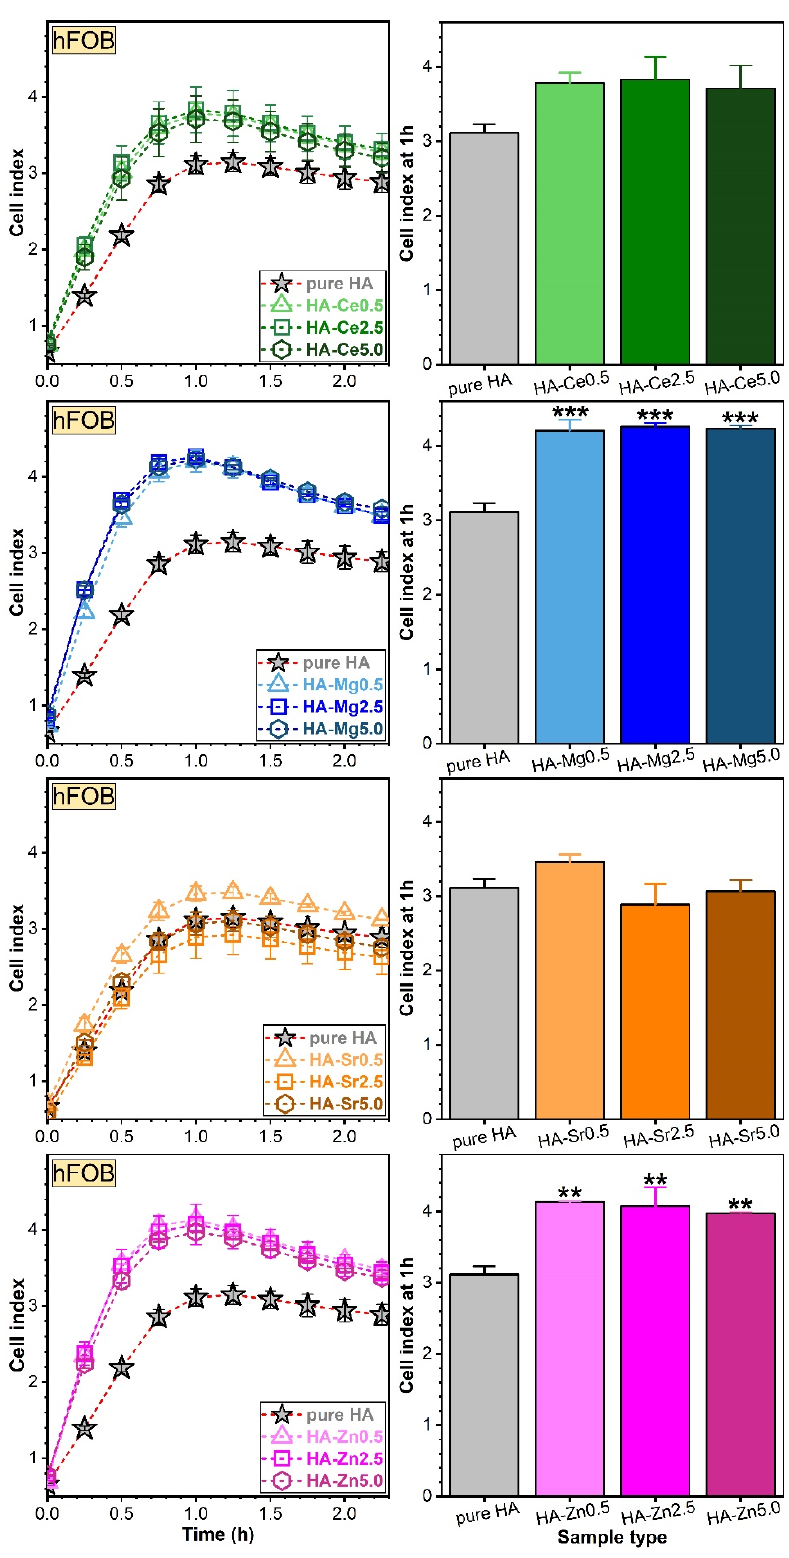
Figure 12. Impedance changes of the real-time cell analysis (RTCA) system mirroring the adhesion of osteoblast (hFOB) cells in the presence of pure HA and Ce-, Mg-, Sr-, or Zn-substituted HA ( left panel ). Cell indices at 1 h were plotted as bars ( right panel ). ** p < 0.01 and *** p < 0.001 statistically significant differences with respect to pure HA (taken as control), as determined by using a one- way ANOVA multiple analysis followed by a Dunnett’s post hoc test.